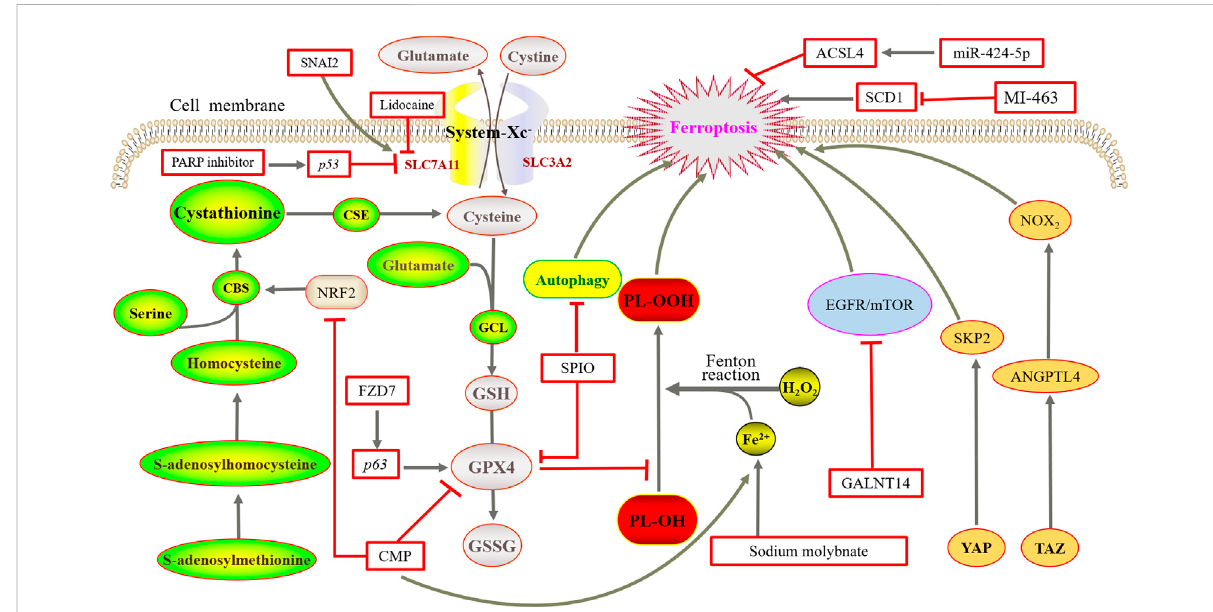
Mechanisms of ferroptosis in ovarian cancer. NRF2 upregulates CBS expression but causes ferroptosis after RNAi knockdown. Overexpression ofFZD7canactivatetheoncogenicfactor P63 ,upregulateGPX4,andavoidundergoingferroptosis.SPIOcouldalsoinduceferroptosisbyattenuated autophagy. Sodium molybdate induced the elevation of LIP. The inhibition or deletion of SCD1 gene could induce ferroptosis. GALNT14 inhibits the EGFR/mTOR pathway, thereby downregulating ferroptosis. TAZ regulates the level of ANGPTL4 to manage the activity of NOX2, and fi nally leads to ferroptosis. YAP promotes ferroptosis by regulating